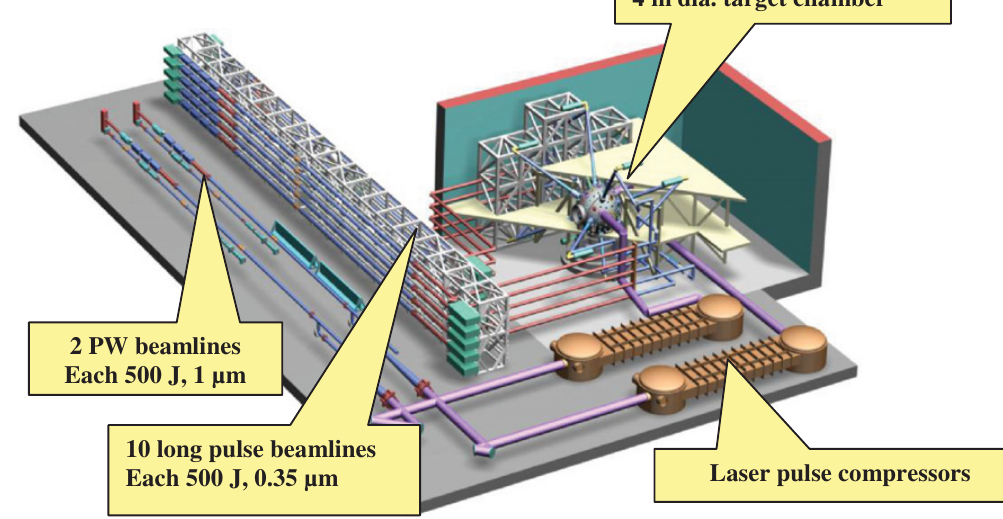
Figure 1. ORION layout and key